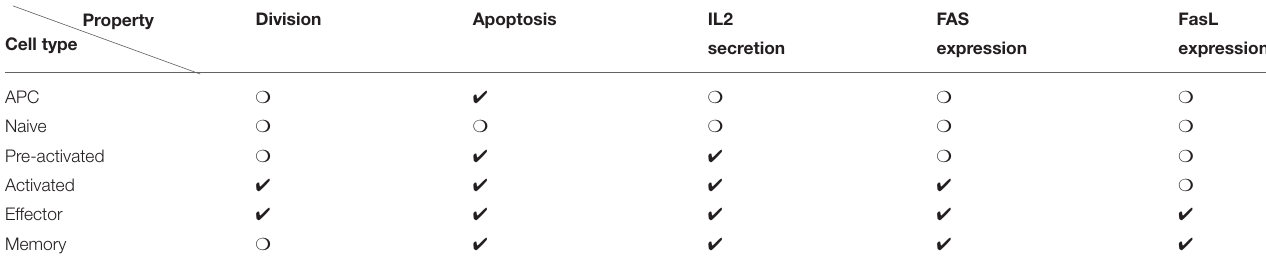
TABLE 2 | Main rules applying to APCs and CD8 T-cells in the model. Property Cell type